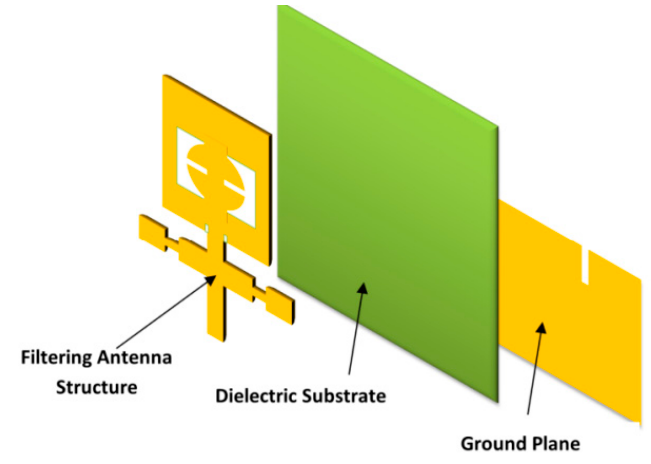
Figure 1. 3 ‐ D view structure of the proposed filtering antenna. Figure 1. 3-D view structure of the proposed filtering